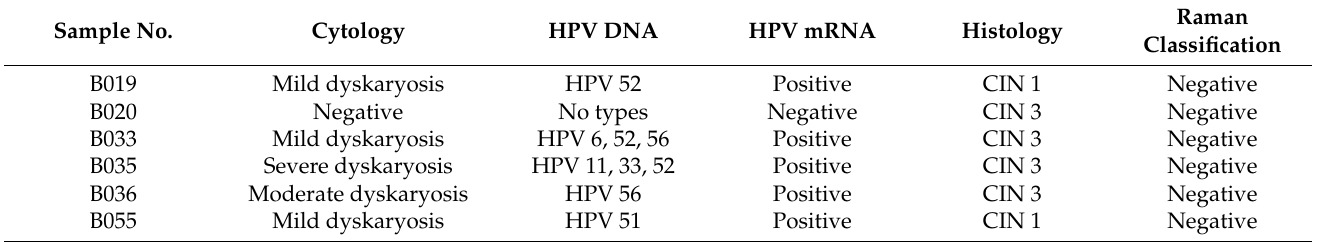
Table 5. Cytology, HPV testing and histology results and Raman classification for the misclassified samples. Sample